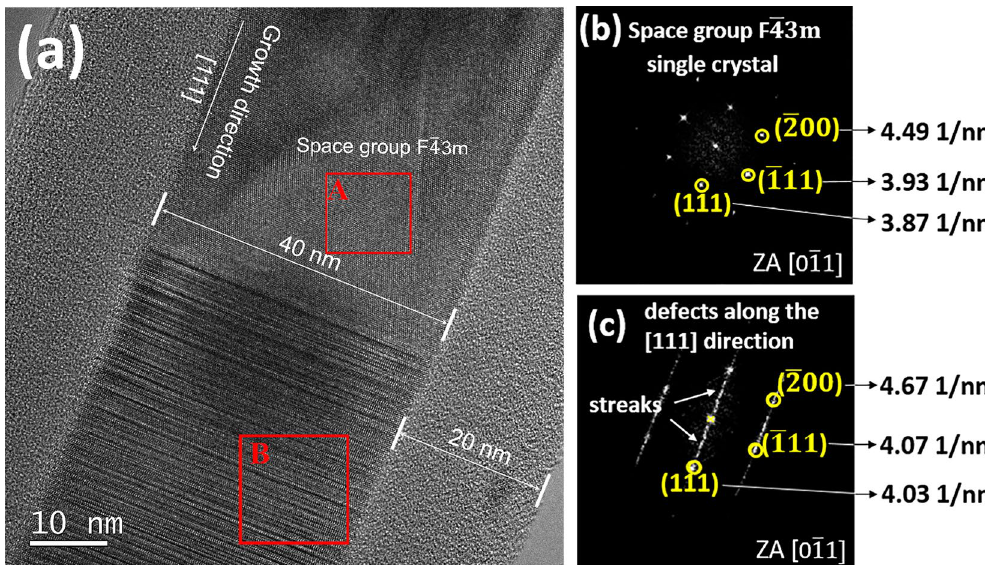
Figure 6. ( a ) The HRTEM image of the nanowire, ( b ) the SAED image of the selected area marked by the red rectangle A in ( a ), showing it consists of a single-crystal structure, ( c ) the SAED image of the selected area marked by the red rectangle B in ( a ), showing the streaks along [111] direction.